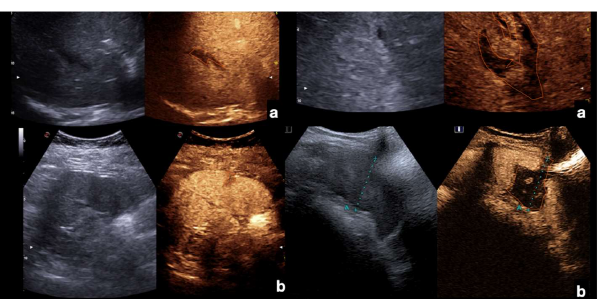
Figure 12. Example of CEUS imaging of low grade (first column) and high grade (second column) injuries in the liver ( a ) and spleen ( b ) after moderate energy blunt trauma. Orange lines indicate parenchymal lacerations/haematomas.